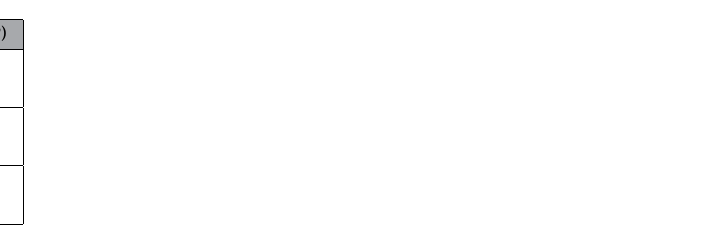
Table 3. Parental allelic transmission to female probands identified by